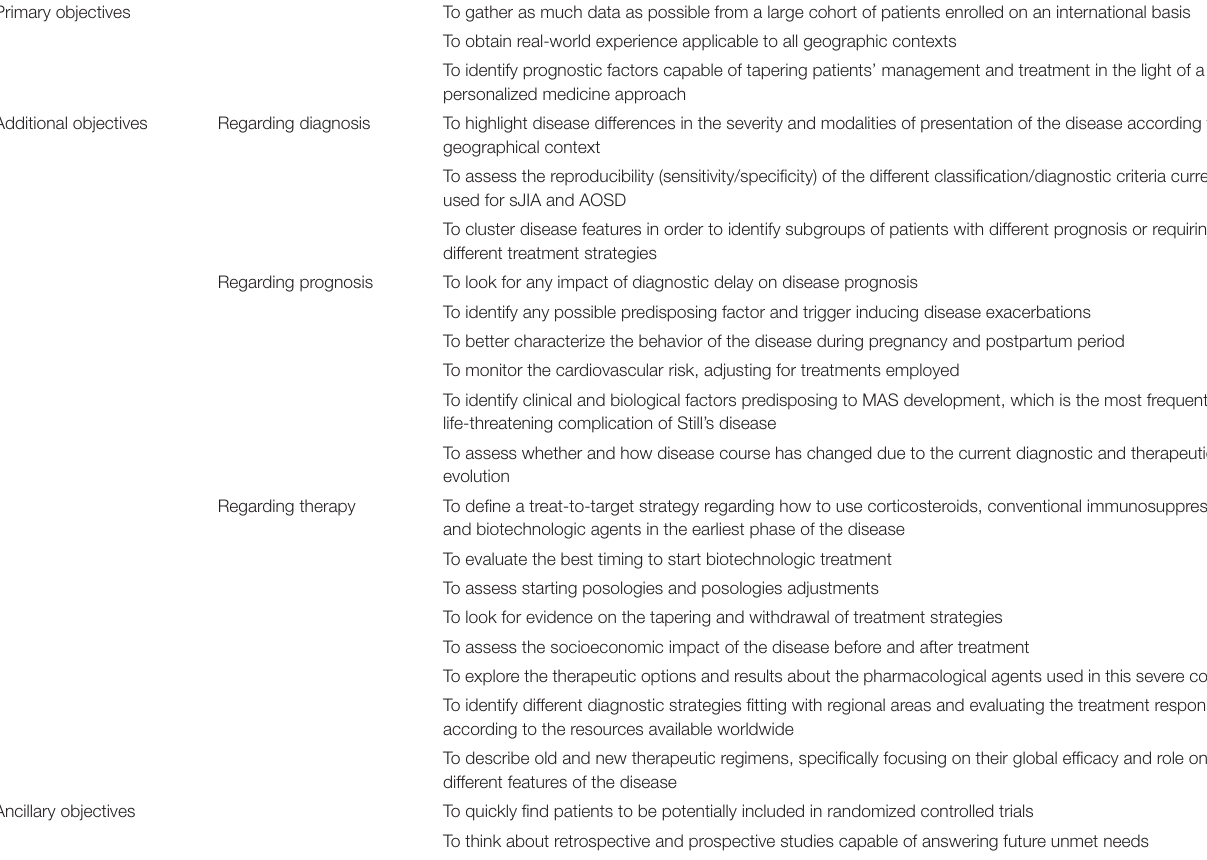
TABLE 1 | List of the objectives that have driven the implementation of the AIDA Registry for patients with Still’s disease. Primary